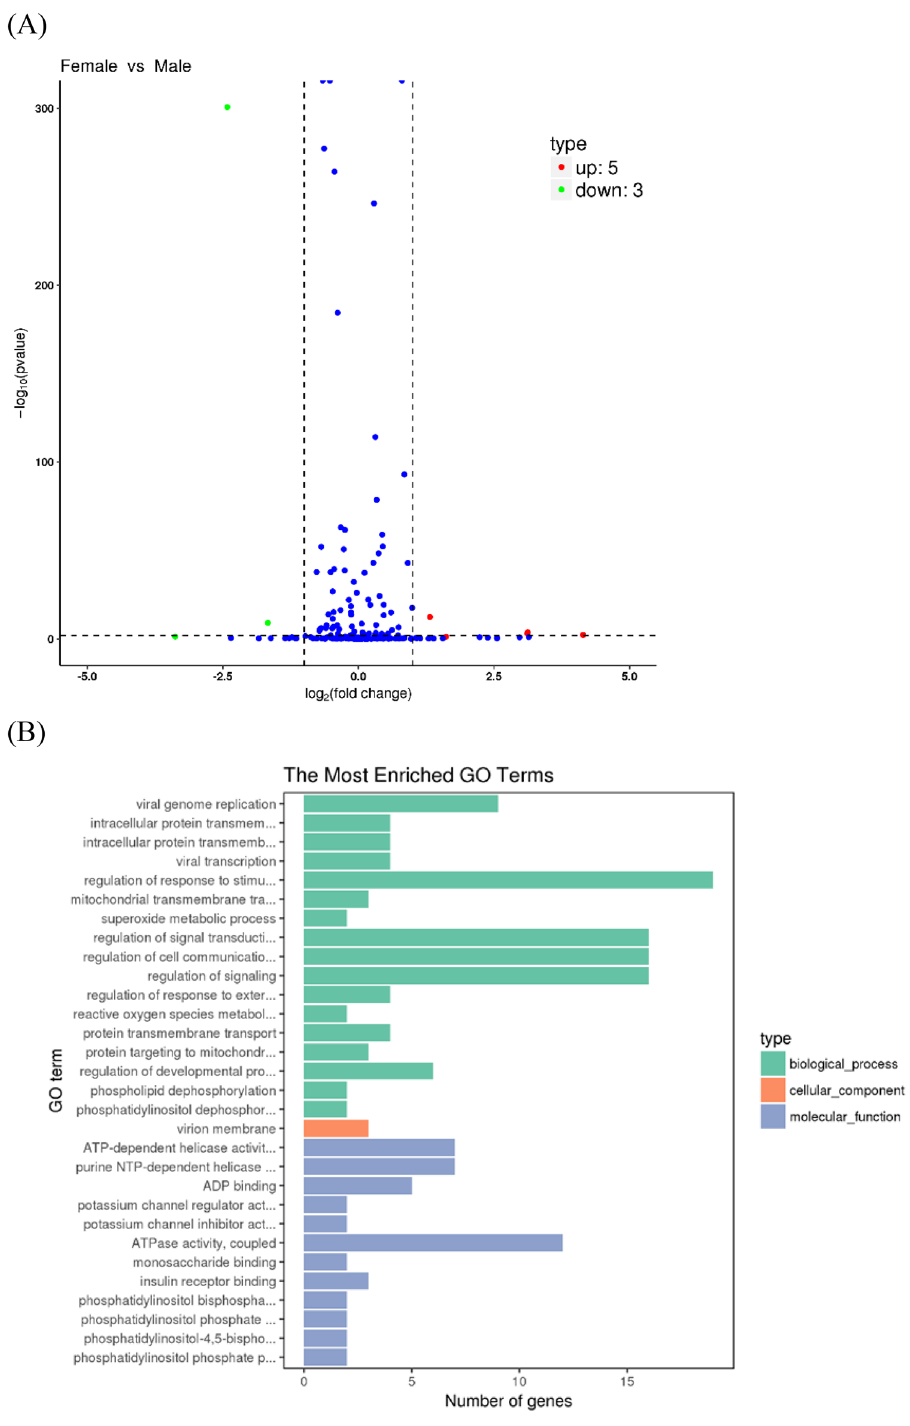
Figure 3. ( A ) Expression of miRNAs in the ovaries and testes of T. rubripes . The x-axis shows the fold change of expression levels between the XX and XY gonads. The y-axis shows the statistical significance of the change in miRNA expression. Blue dots indicate miRNAs that were equally expressed, red dots indicate upregulated miRNAs in XX gonads, and green dots indicate downregulated miRNAs in XX gonads. ( B ) Gene ontology (GO) analysis of the predicted target genes of the differentially expressed miRNAs. The GO enrichment of the predicted target genes in molecular functions, cellular components, and biological processes is